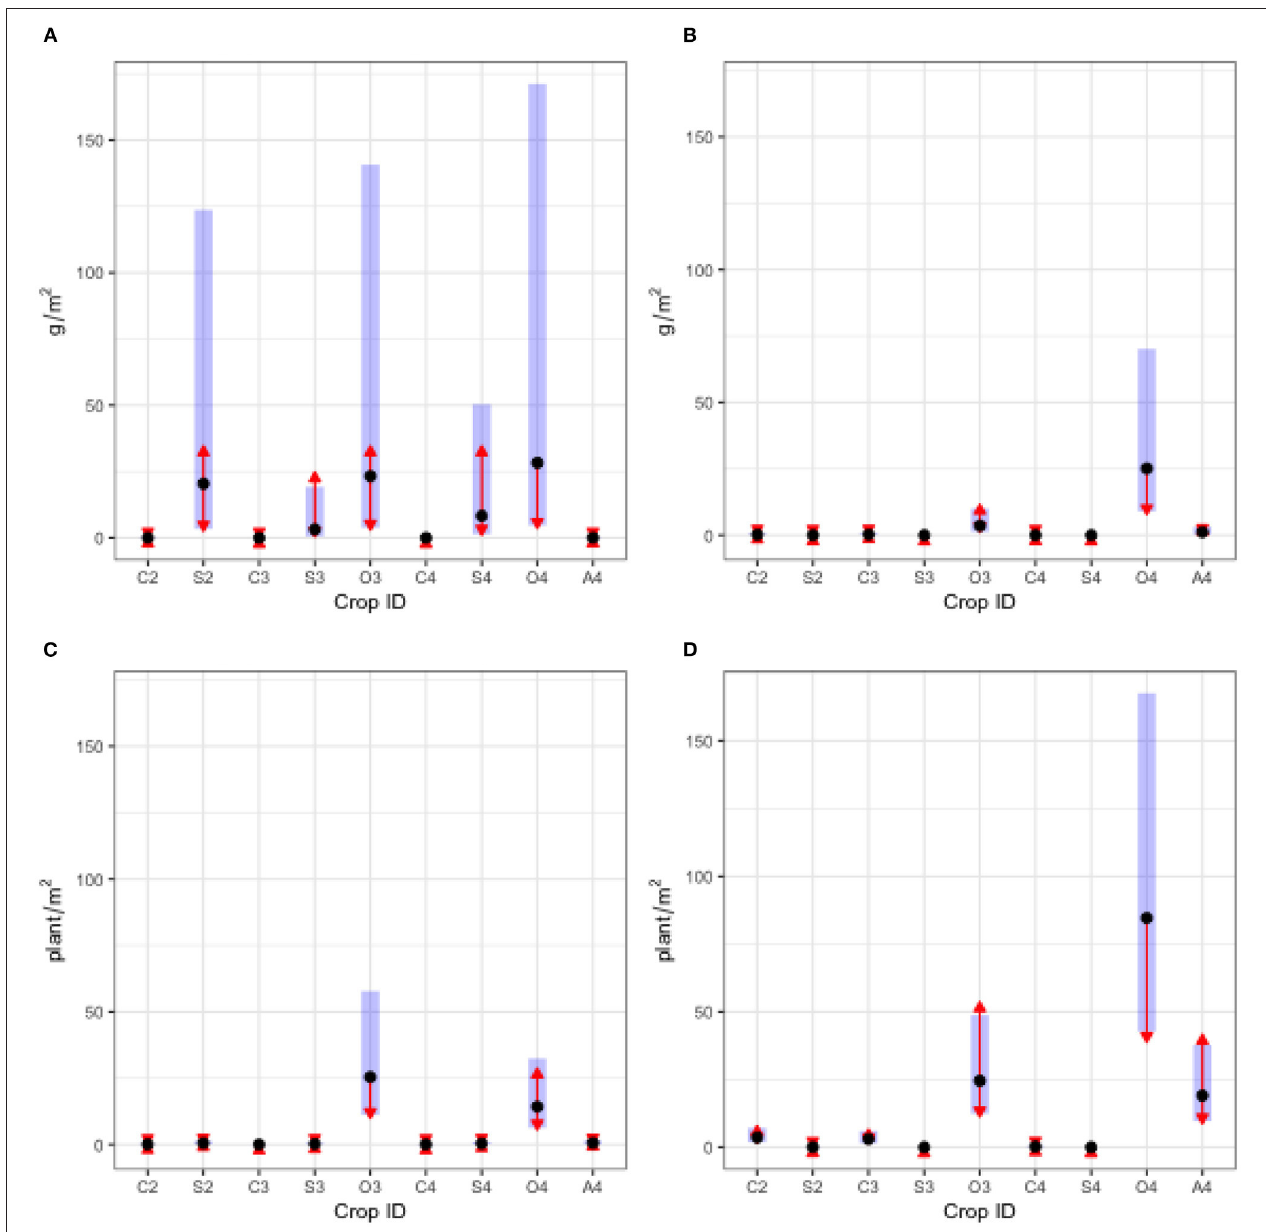
FIGURE 2 | Waterhemp population aboveground mass and stand density averaged over corn weed managements. The abbreviations on the x -axis are crop identities, which are the combinations of the first letter in crop species names and the rotation to which the crops belonged (C2, corn in the 2-year rotation; C3, corn in the 3-year rotation; C4, corn in the 4-year rotation; S2, soybean in the 2-year rotation; S3, soybean in the 3-year rotation; S4, soybean in the 4-year rotation; O3, oat in the 3-year rotation; O4, oat in the 4-year rotation; and A4, alfalfa in the 4-year rotation). The black dots are estimated marginal means. The blue bars are 95% confidence intervals. The red arrows reflect the comparison among means. Overlapping arrows indicate non-significant differences. (A) , 2018 population above ground mass; (B) , 2019 population above ground mass; (C) , 2018 population stand density; (D) , 2019 population stand density.